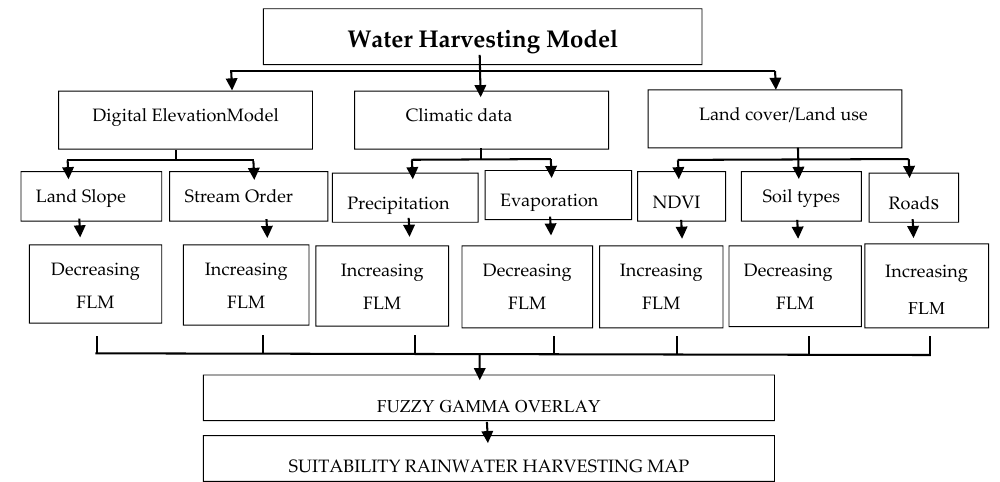
Figure 10. Rainwater harvesting model using Fuzzy Gamma overlay.